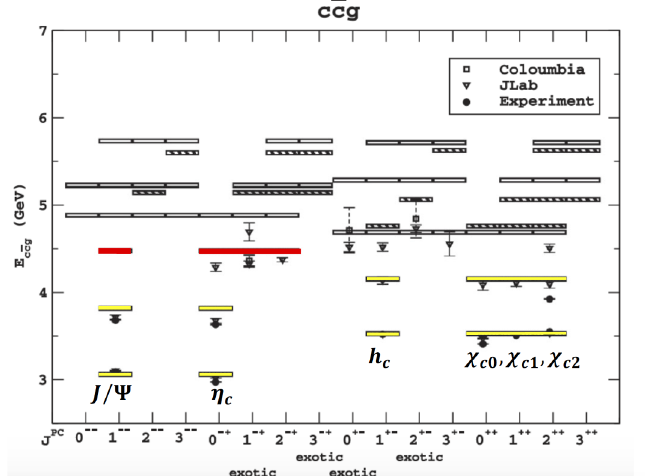
Figure 1. Charmonium (yellow boxes) and charmonium hybrid spectrum compared with data (where available) or lattice computations. The c ¯ c lightest states, J / Ψ ,η c , h c and χ c , J are indicated explicitly. Red boxed are the lightest c ¯ c g hybrid supermultiplet. Open boxes are the c ¯ c g hybrids dominated by the S-wave quarks, all other (dashed boxes) have the Q ¯ Q pair in the relative P-wave orbital. Figure adapted from [19], APS